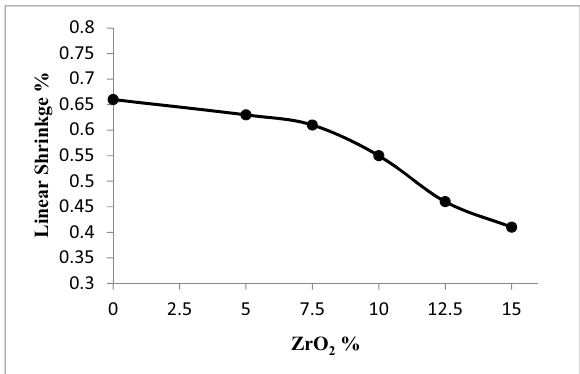
Figure 6: Linear shrinkage for various ZrO 2 additions in refractory specimens.